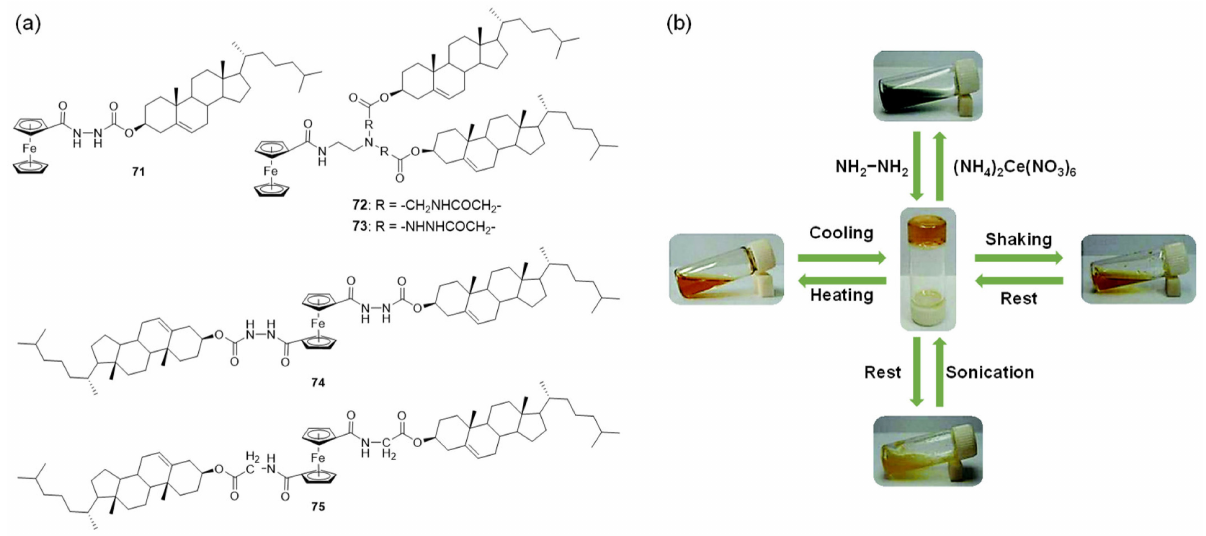
Figure 30. ( a ) Cholesterol-appended ferrocene gelators 71 – 75 . ( b ) Reversible sol–gel phase transition of the gel of 71 /cyclohexane, triggered by chemical redox reaction, shear stress, sonication and temperature. Reprinted with permission from Ref. [101]. Copyright (2008), John Wiley and